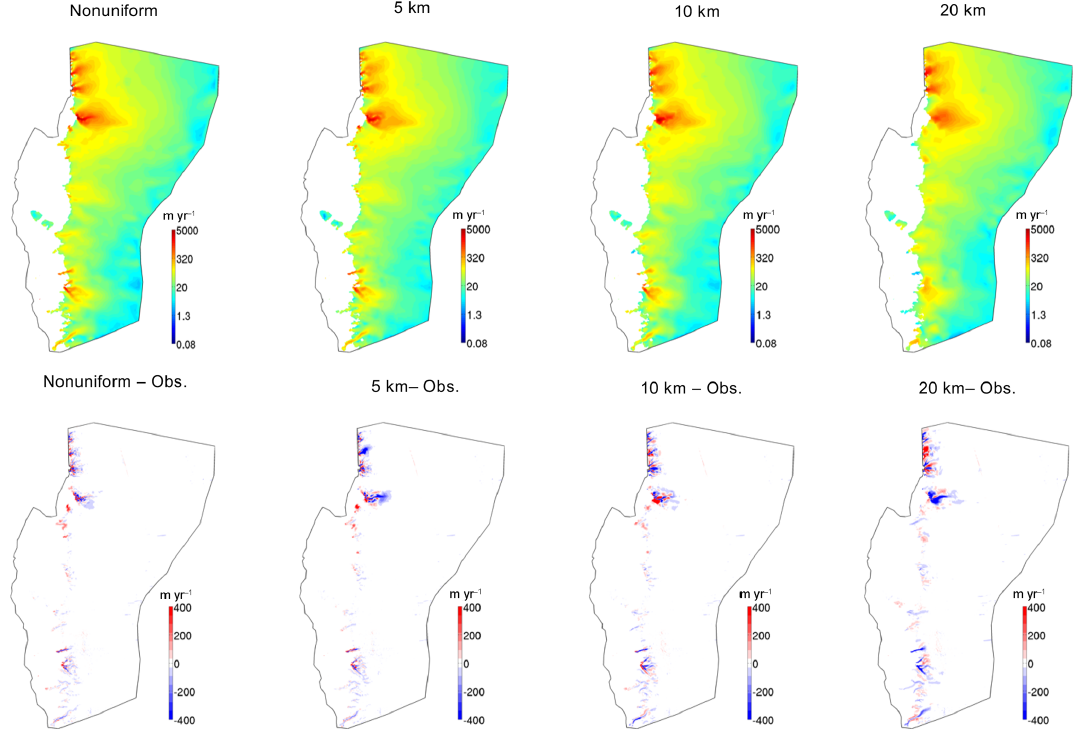
Figure 3. Present-day steady-state ice surface velocities for each individual model and their differences from observations (Rignot and Mouginot, 2012, shown in Fig. 1).